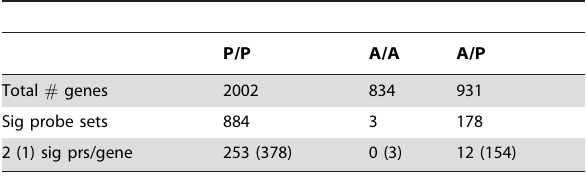
Table 2. Relationship between P/A calls and significance for differential expression for genes with two probe sets.